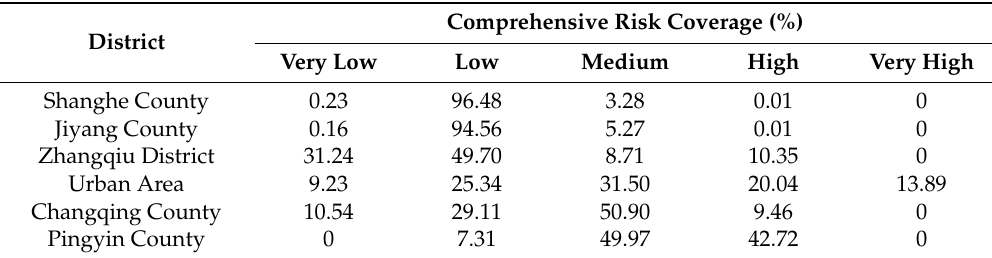
Table 9. Comprehensive statistical risk level in different district.